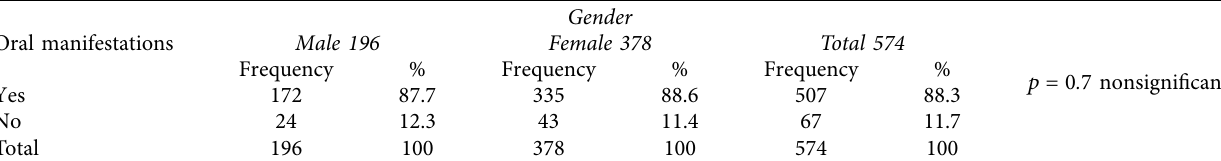
Table 1: Frequency, percentage, and the statistical diference of examined and afected males and females. Oral manifestations